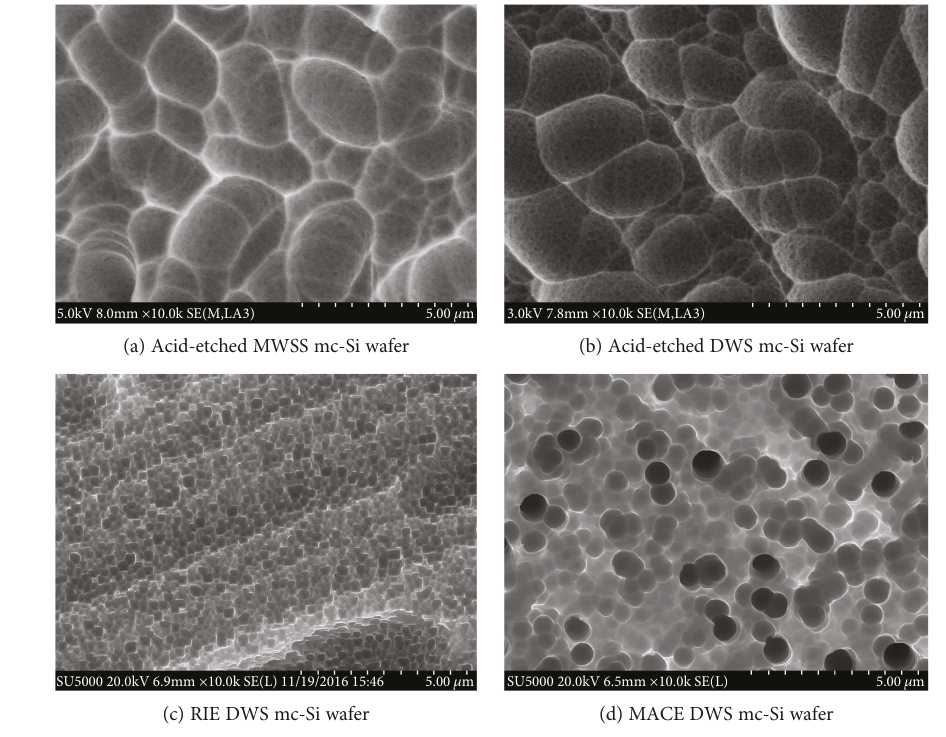
Figure 1: SEM pictures of di ff erent surface structures.